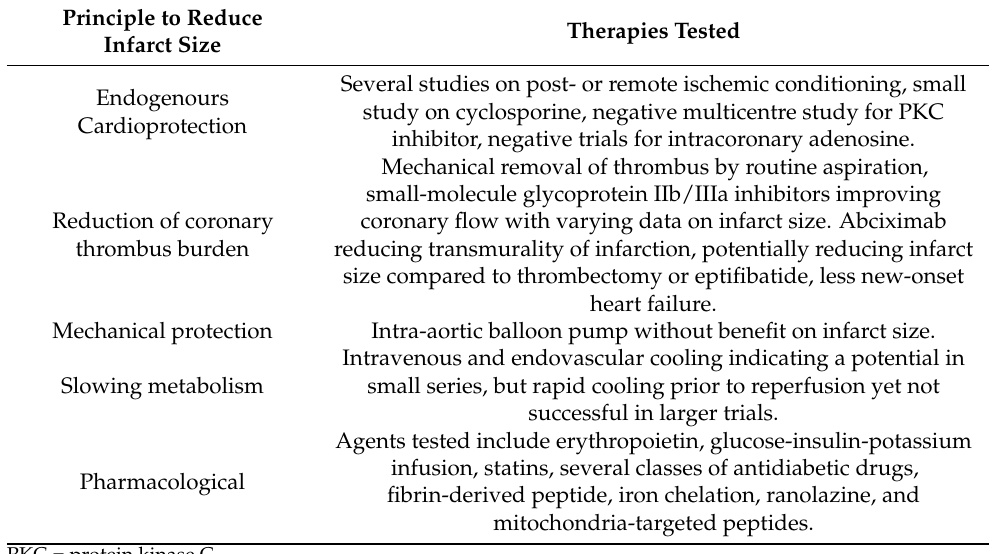
Table 1. Previous therapeutic strategies to reduce infarct size, which were successful in experimental models but failed in clinical